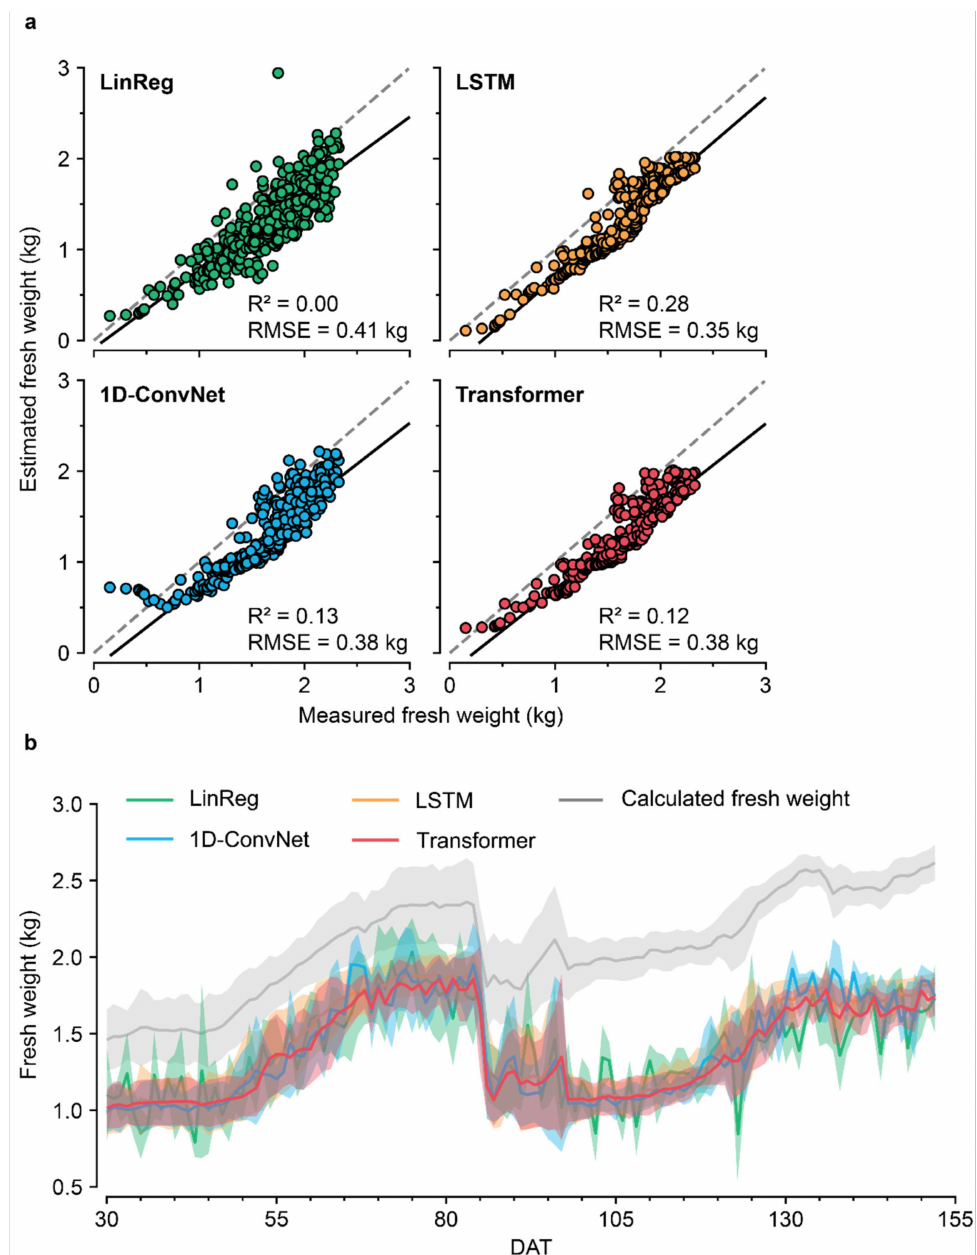
Figure 6. ( a ) Test accuracies of the trained deep learning models for estimating calculated fresh weights from 25 August 2020 to 24 January 2021 (2020W). ( b ) Comparison of the estimations based on days after transplanting (DAT). The standard deviation of the day is represented by a shaded area. LinReg, LSTM, and ConvNet represent linear regression, long short-term memory, and convolution neural network,